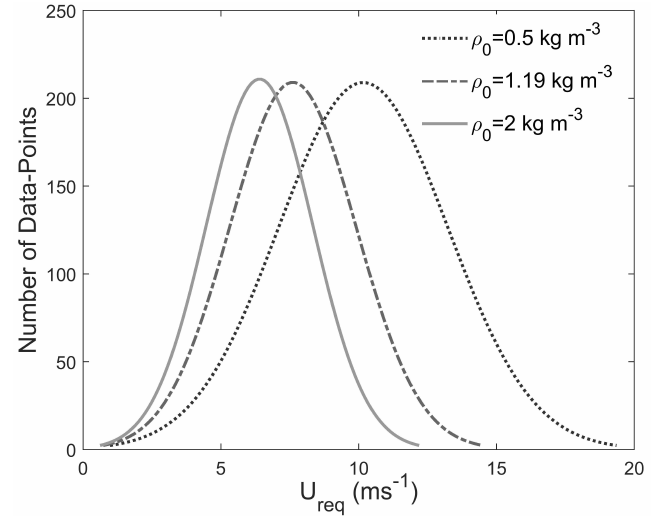
Figure 10. Distribution of rotor equivalent wind speed for three different values of ρ 0 . Smaller value of ρ 0 results in wider distribution of U req .